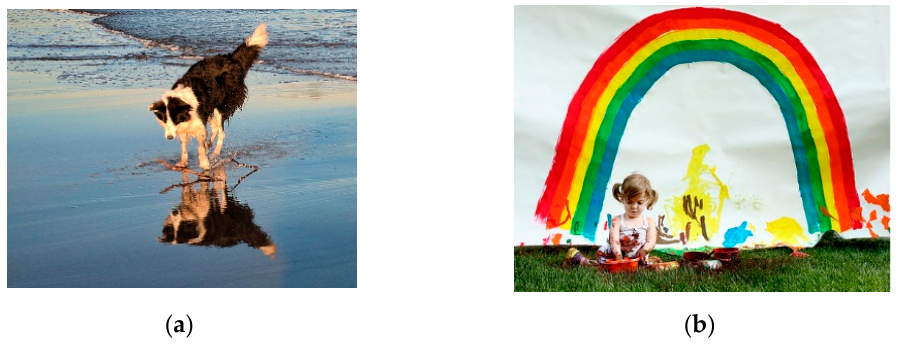
Figure 10. Training samples in Flickr 8 k [24]: ( a ) caption: “A dog at the beach”; and ( b ) caption: “A little girl covered in paint sits in front of a painted rainbow with her hands in a bowl.”.